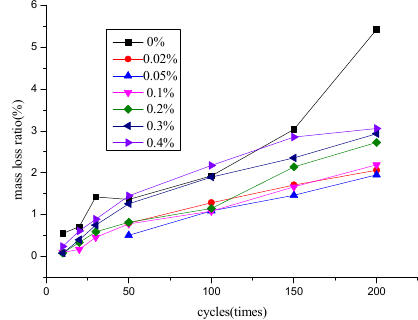
Figure 6. Mass loss ratio of concrete versus F-T cycles.